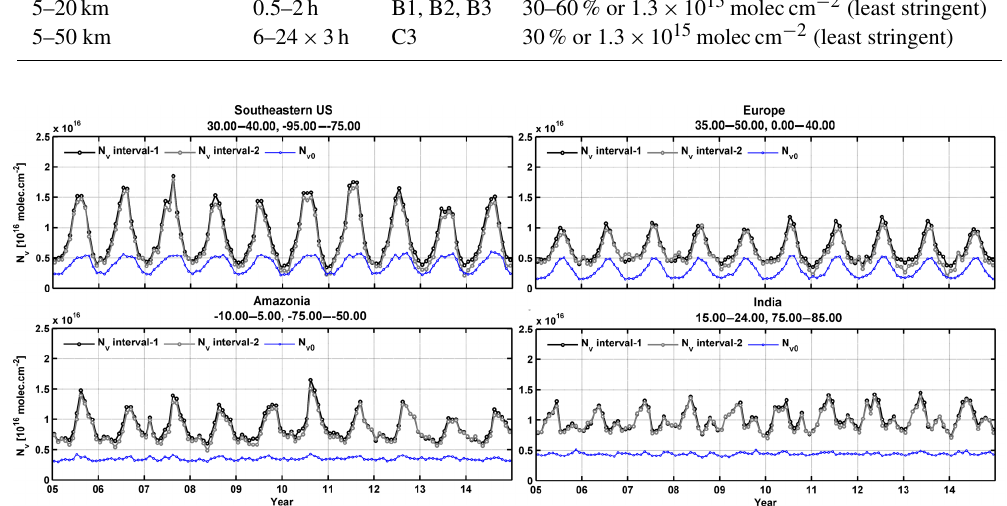
Figure 3. Example of regional and monthly averages of the HCHO vertical columns over different NMVOC emission regions, derived from OMI observations for the period 2005–2014. Results of the retrievals in the two fitting intervals (1: 328.5–359nm and 2: 328.5–346nm, with BrO fitted in interval 1) are shown, as well as the magnitude of the background vertical column ( N v, 0